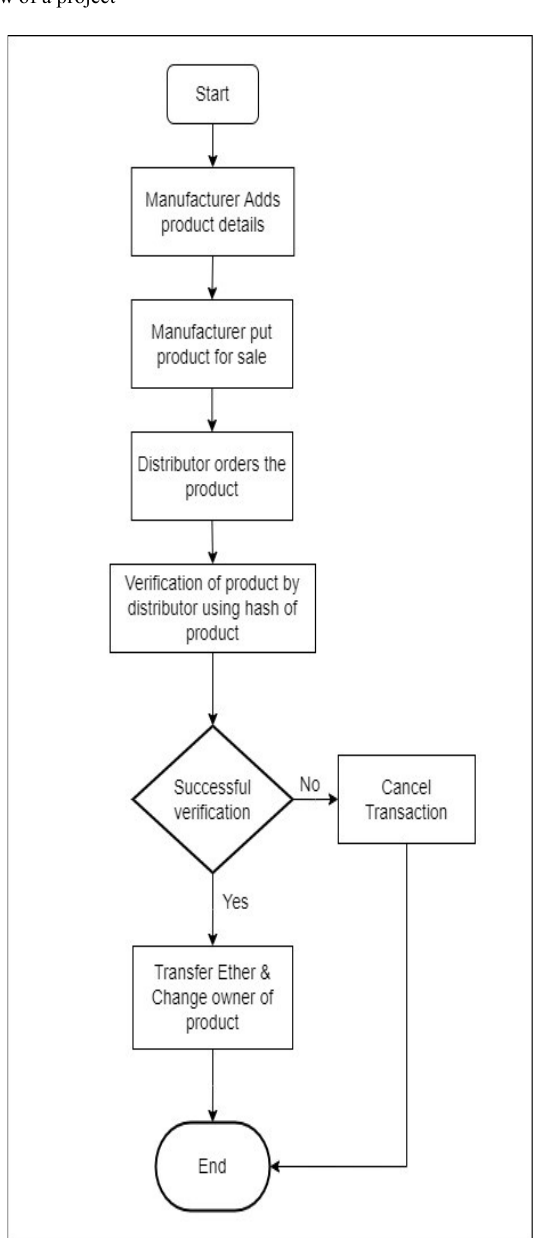
Fig. 6. Shows transaction and transfer of ownership between 2